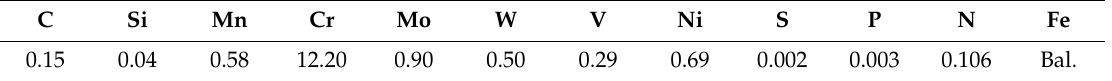
Table 1. Chemical composition of 15Cr12MoVWN steel